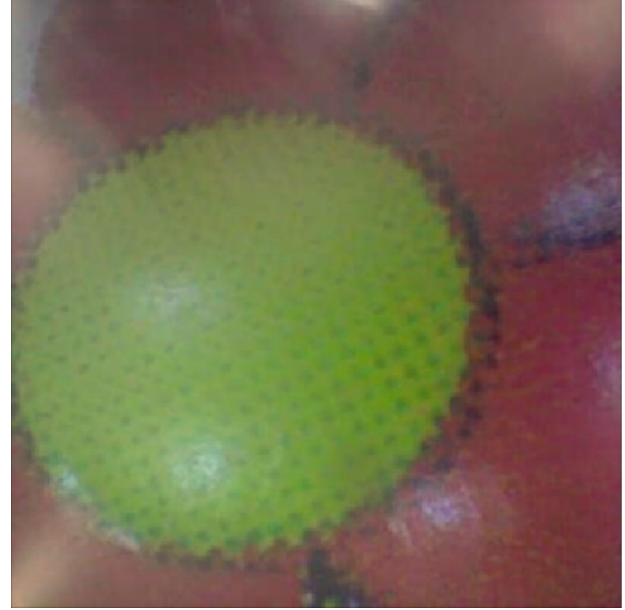
Figure 17. Image capture from WCE.